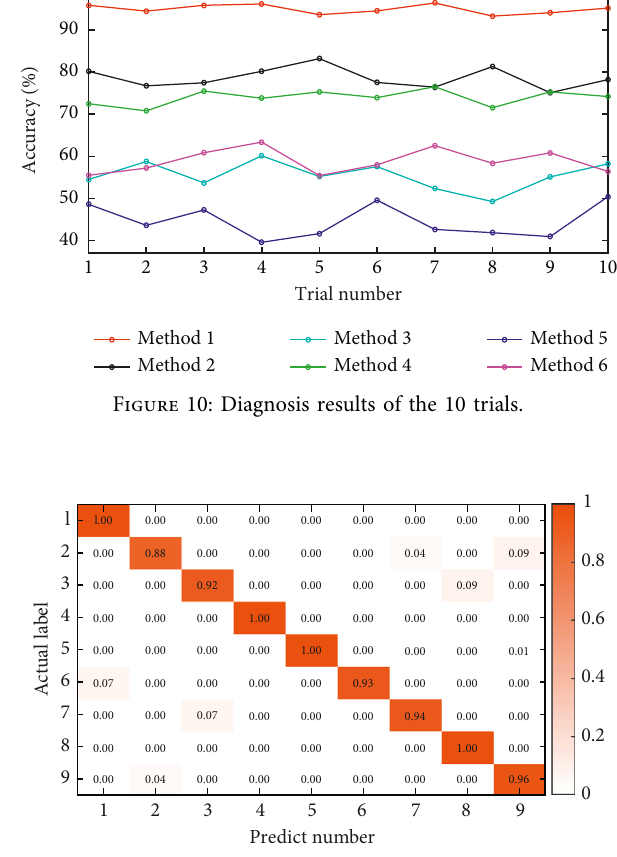
Figure 11: The confusion matrix using the proposed method (the first trial). Table 2: Comparison of methodologies.